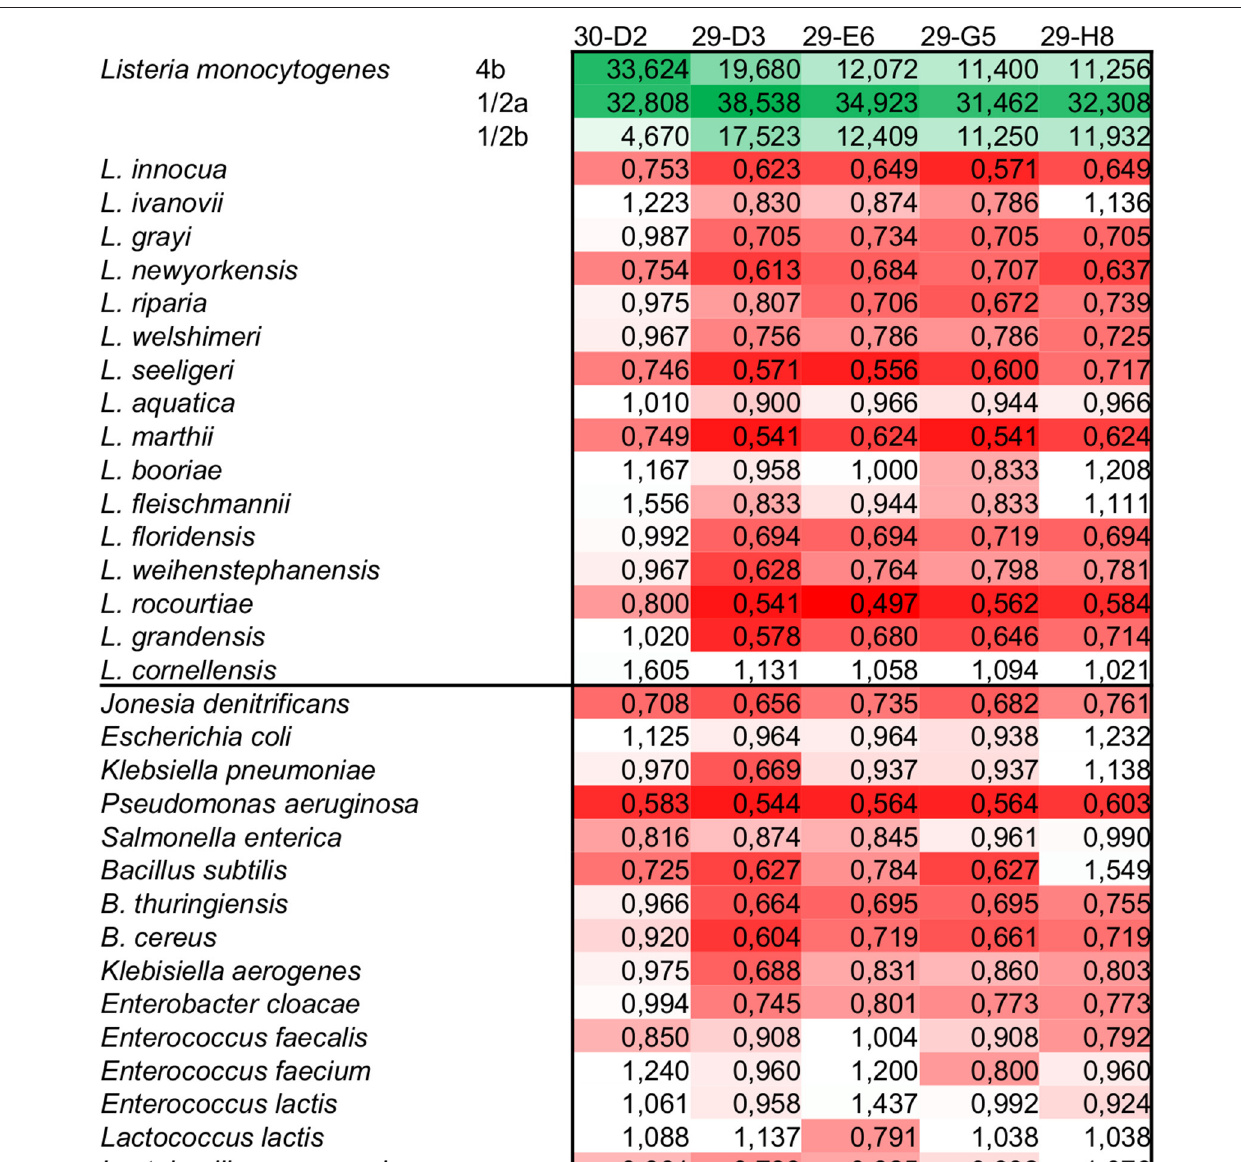
FIGURE 2 | Signal-to-noise ratio of the scFv-Fc tested using the highest concentration (EC 50 L. monocytogenes . Depending on the serotype and target used, the signals were from 4 up to more than 35 times higher than the negative reactions. The color scale goes from green (higher reaction) to red (lower reaction) going through white (signal-to-noise ratio Both InlA and InlB are the most studied proteins for